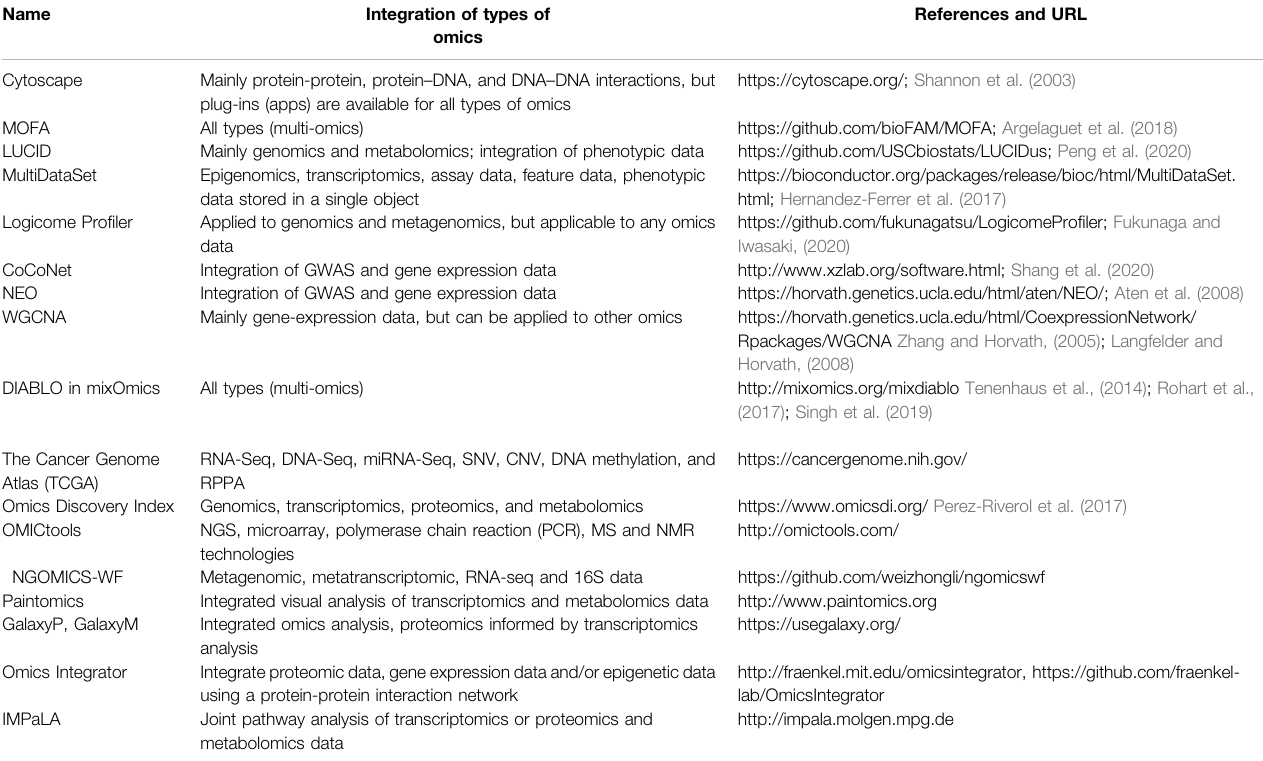
TABLE 2 | Overview of some free bioinformatics software for integrating information across several omics